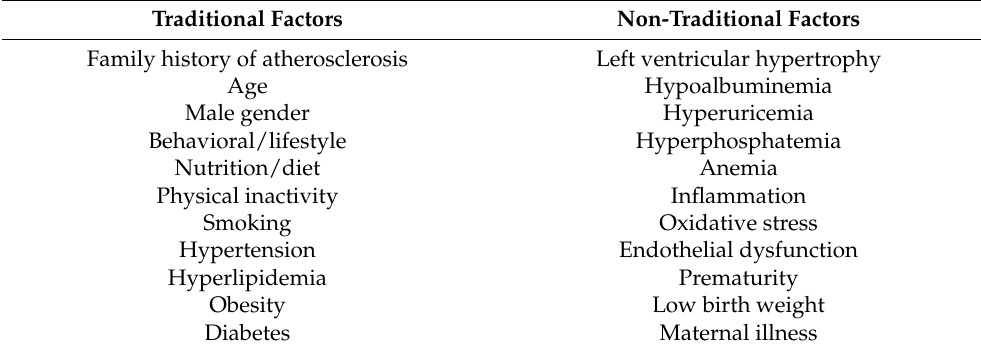
Table 1. Risk Factors for Cardiovascular Disease in Children with Chronic Kidney Disease.